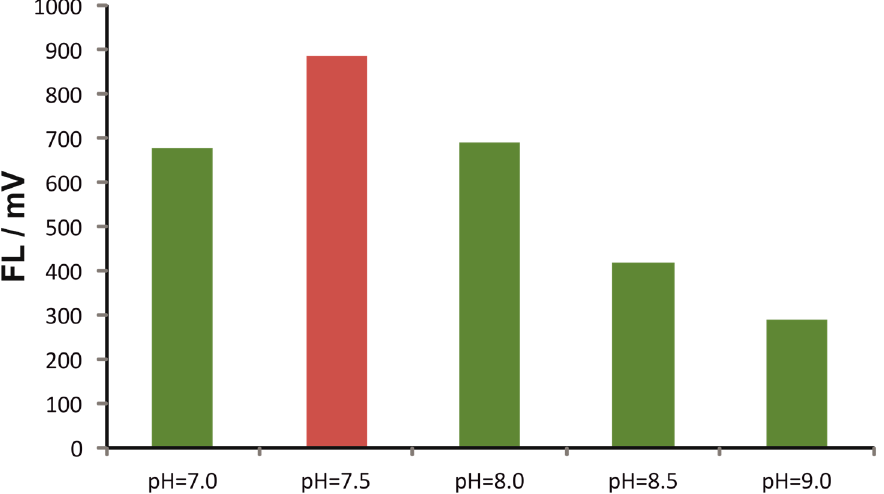
Figure 1. Effect of the pH on the fluorescence intensity of histidine– o -phthalaldehyde (HIS–OPA) derivative under flow conditions.